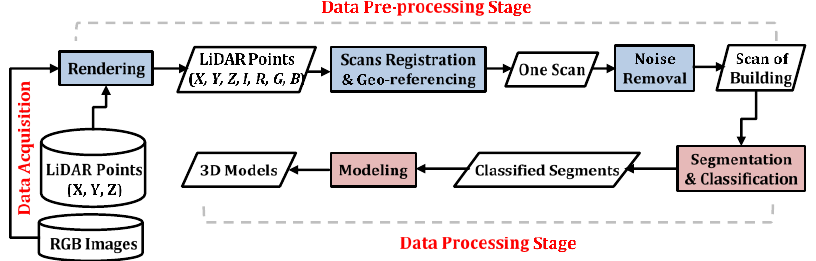
Figure 1. Typical scan-to-BIM workflow. The data pre-processing stage is in blue color and the data processing stage is in magenta color.